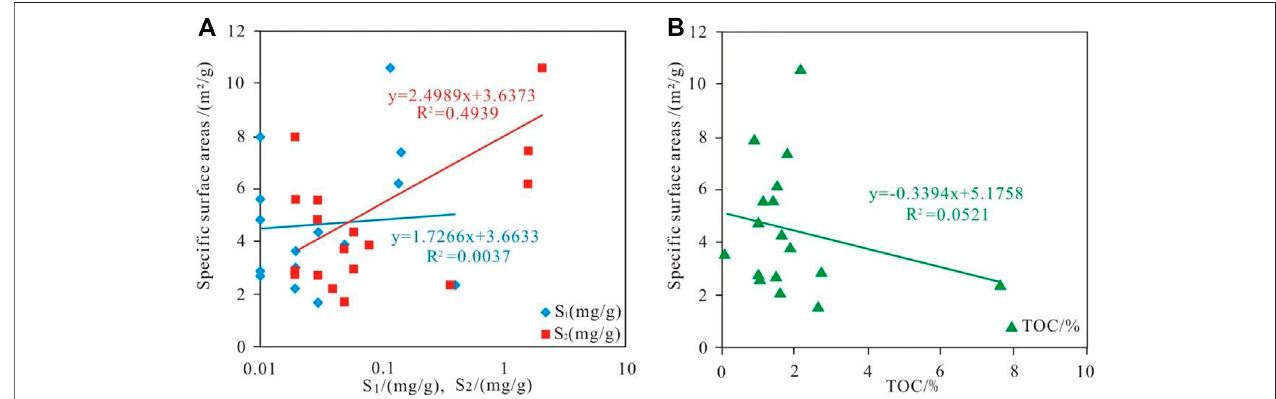
FIGURE 15 | Correlation of the average fractal dimensions with S 1 , S 2 , and TOC of Shanxi Formation. Average fractal dimensions with (A) S 1 and S 2 , (B) TOC.